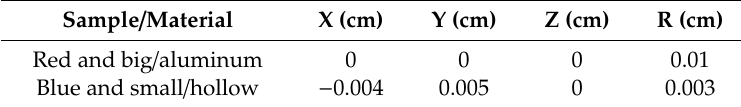
Table 2. The spherical sample parameters used in